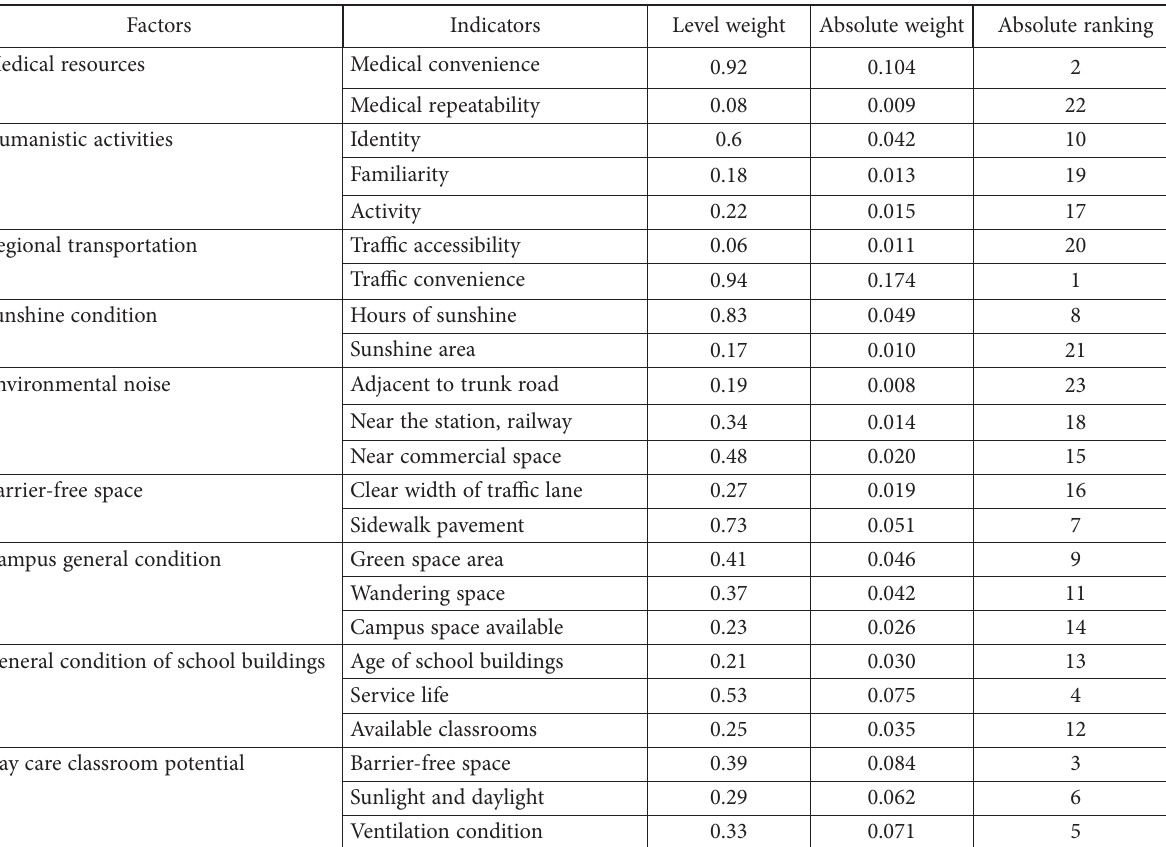
Table 5. Third level weights and